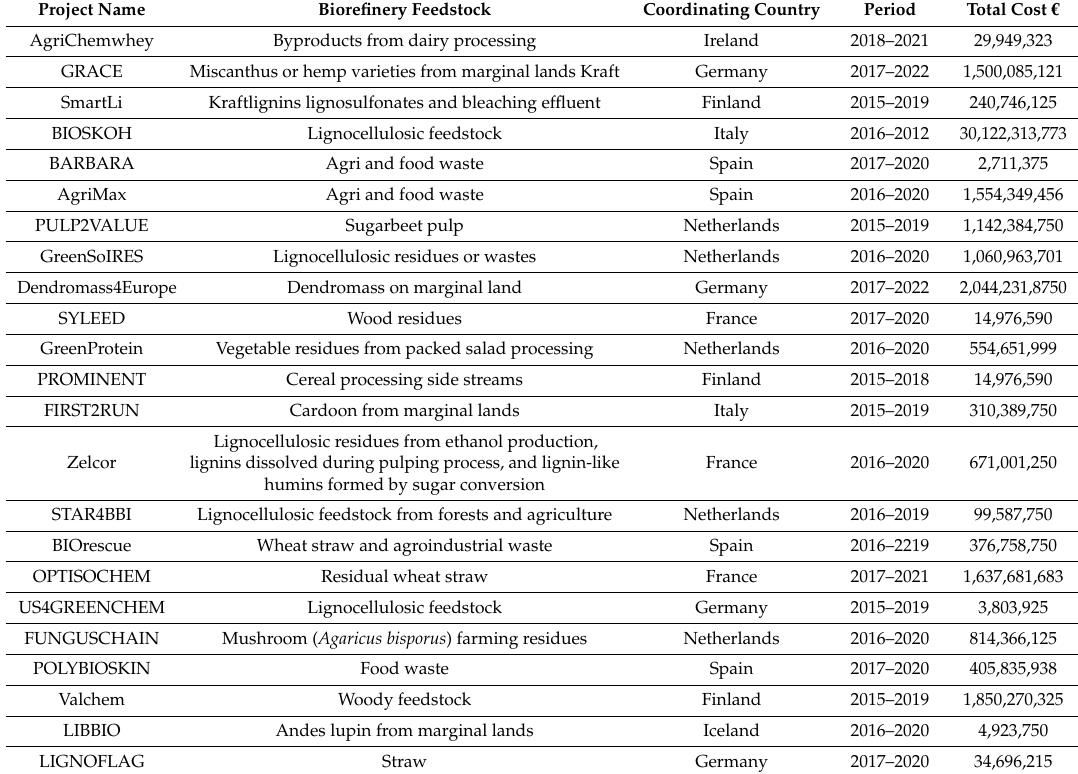
Table 4. Projects funded by the EU for using lignocellulosic feedstocks in the biorefinery industry. Adapted from